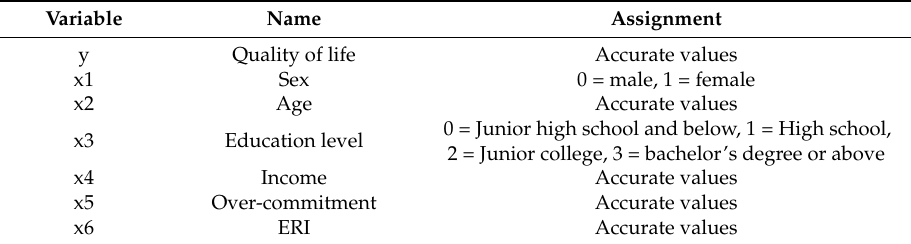
Table 6. Assignment of factor-specific variables.